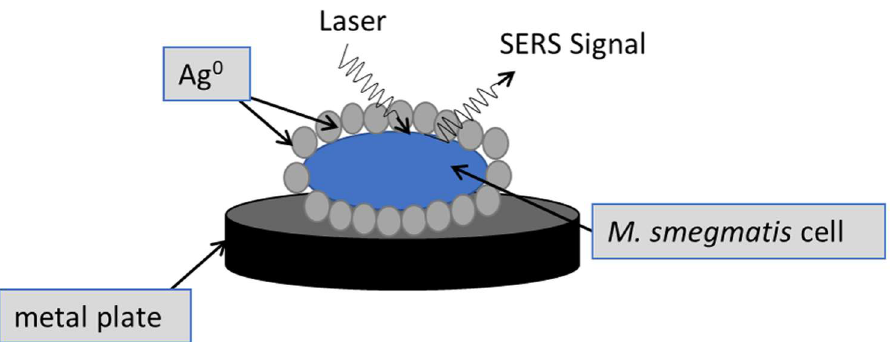
Figure 3. Diagram showing the formation of silver particles by chemical reduction and coating the M. smegmatis cells with Ag nanoparticles to enhance the Raman